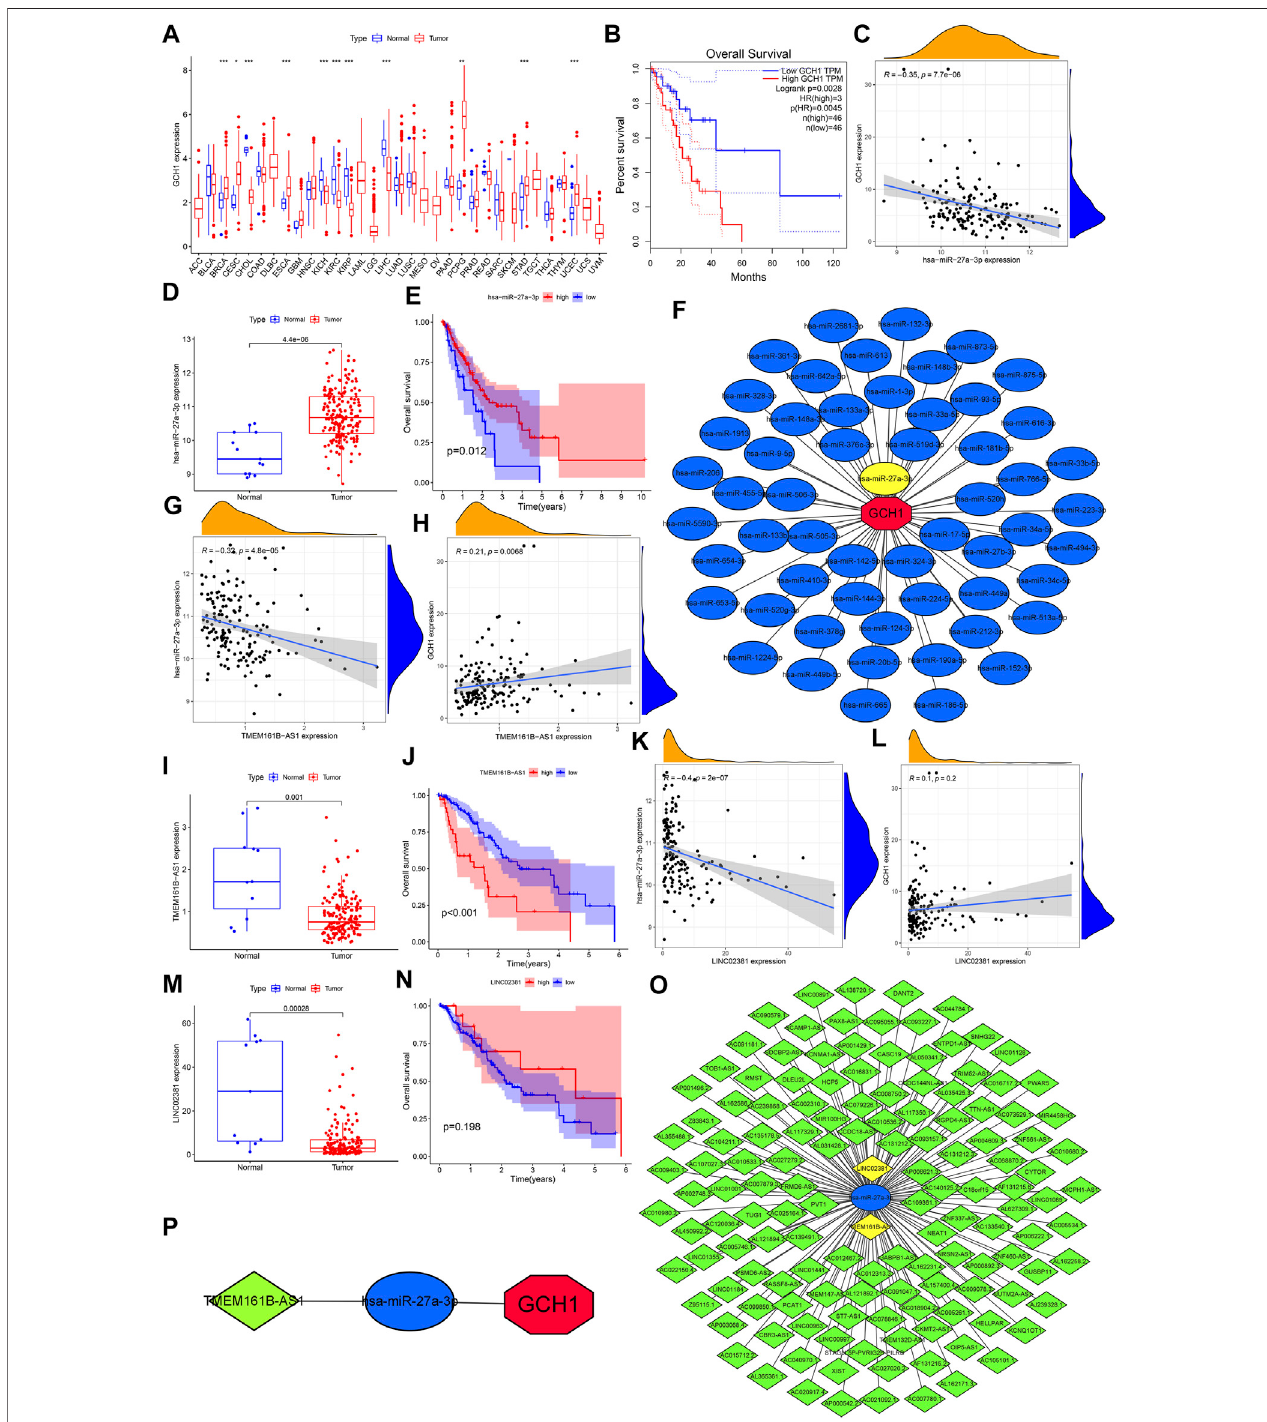
FIGURE 7 | Prediction and validation of ceRNA regulatory network. (A) Difference in GCH1 expression between normal and tumor tissue across 33 cancer types. (B) Survival rates for levels of high and low GCH1 expression. (C) Correlation between GCH1 and hsa-miR-27a-3p expression. (D) Expression level of has-miR-27a-3p for normal versus ESCA tissue. (E) Survival rates for levels of high and low hsa-miR-27a-3p expression. (F) Regulatory network of miRNAs-GCH1. (G) Correlation between expression of TMEM161B-AS1 and hsa-miR-27a-3p. (H) Correlation between expression of TMEM161B-AS1 and GCH1. (I) TMEM161B-AS1 expression between normal and ESCA tissue. (J) Survival rates between groups with high and low expression of TMEM161B-AS1. (K) Correlation between expression of LINCO2381 and hsa-miR-27a-3p. (L) Correlation between expression of LINCO2381 and GCH1. (M) Expression levels of LINCO2381 for normal and ESCA tissue. (N) Survival rates between groups with high and low expression of LINCO2381. (O) Regulatory network of lncRNAs- hsa-miR-27a-3p. (P) ceRNA regulatory network genes include TMEM161B-AS1, hsa-miR-27a-3p and GCH1. The expression level of all genes refers to the transcription level of RNA.